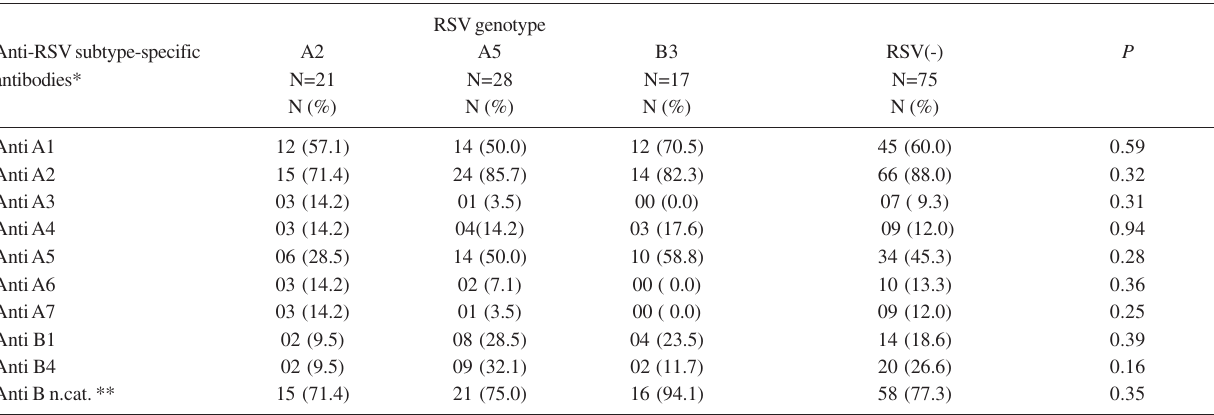
Table 3 - Prevalence of anti-RSV subtype-specific antibodies in the sera of infants infected with the most frequently found RSV genotypes.